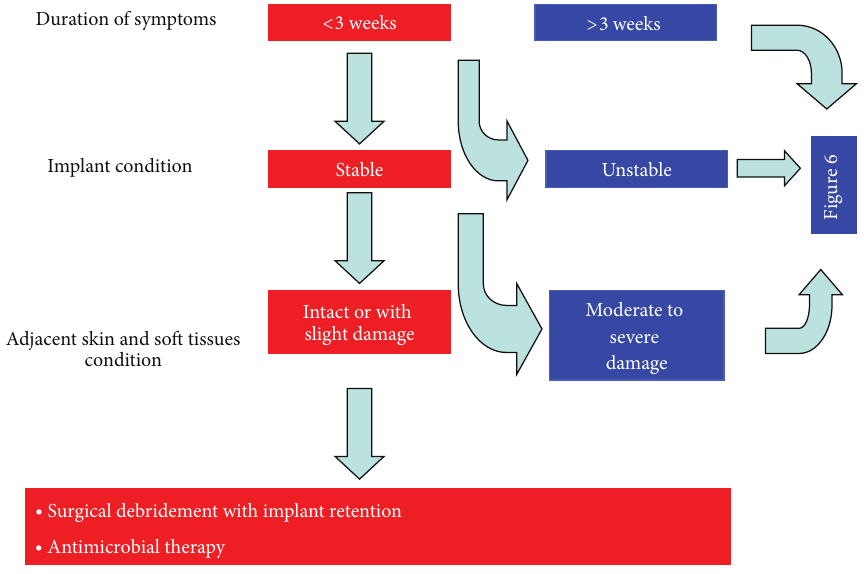
Figure 5: Management of acute periprosthetic joint infections.